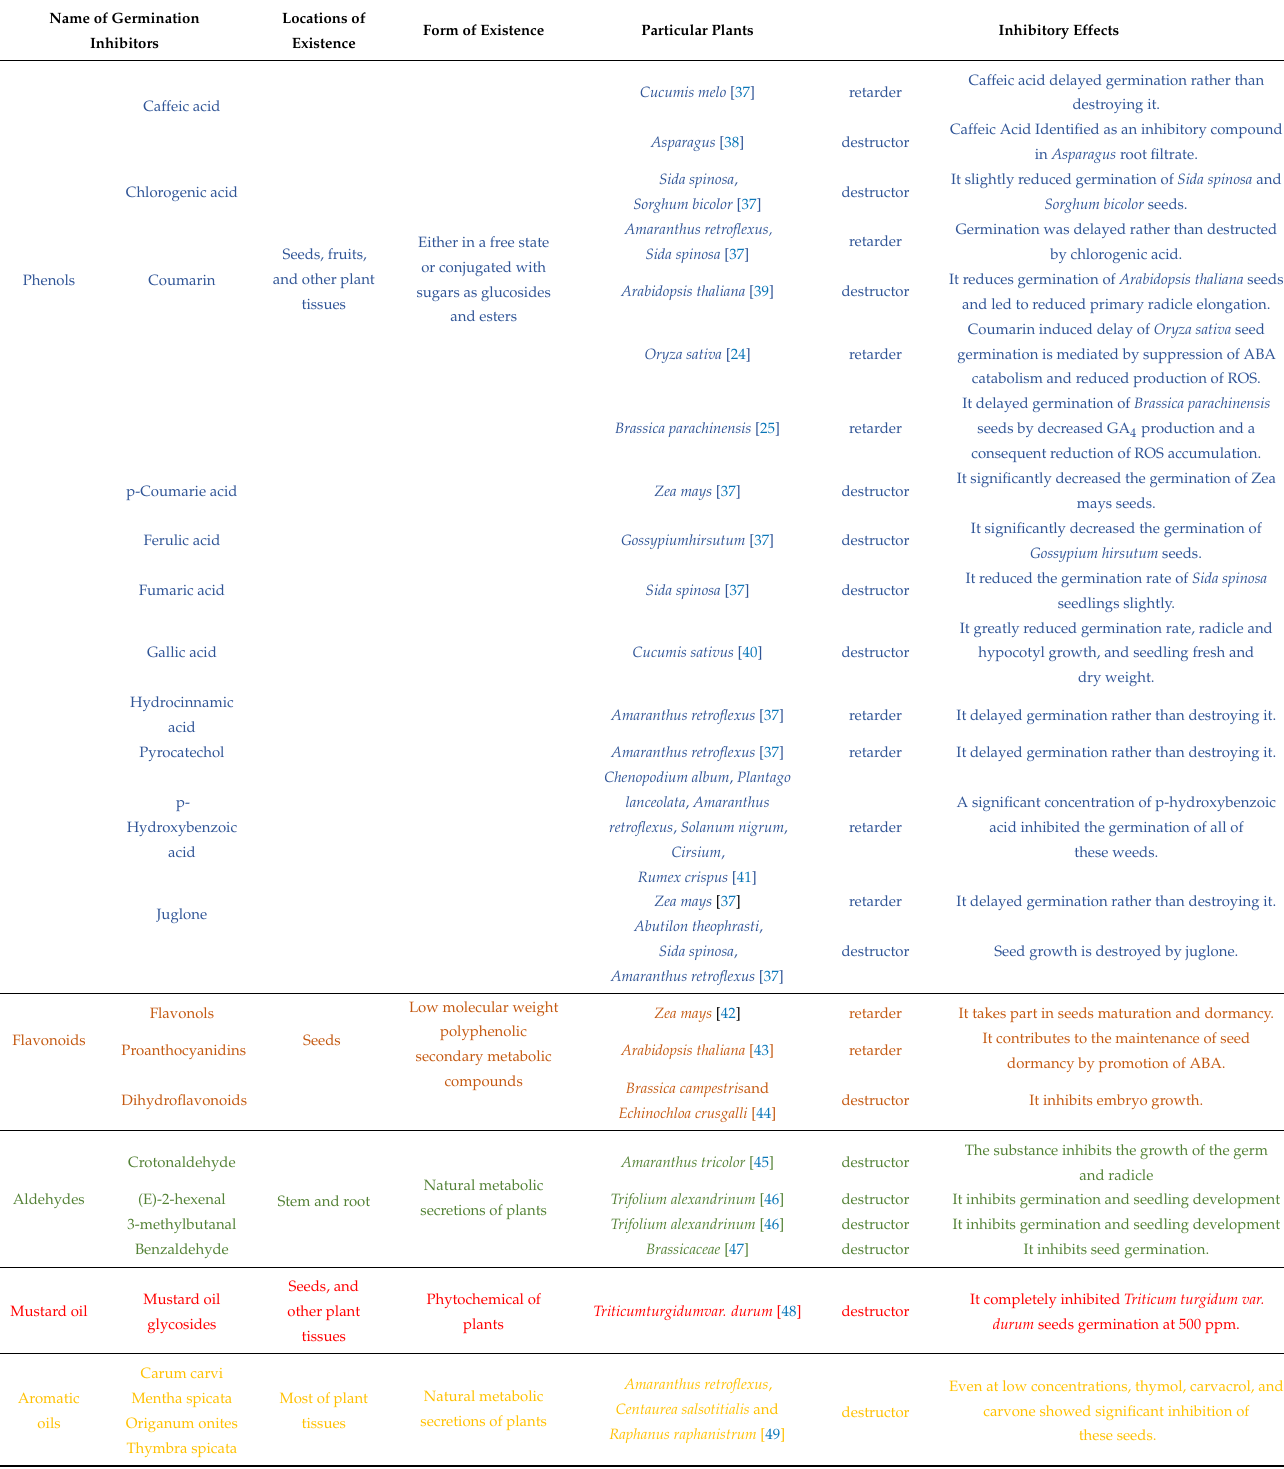
Table 2. Classification of germination inhibitors by chemical